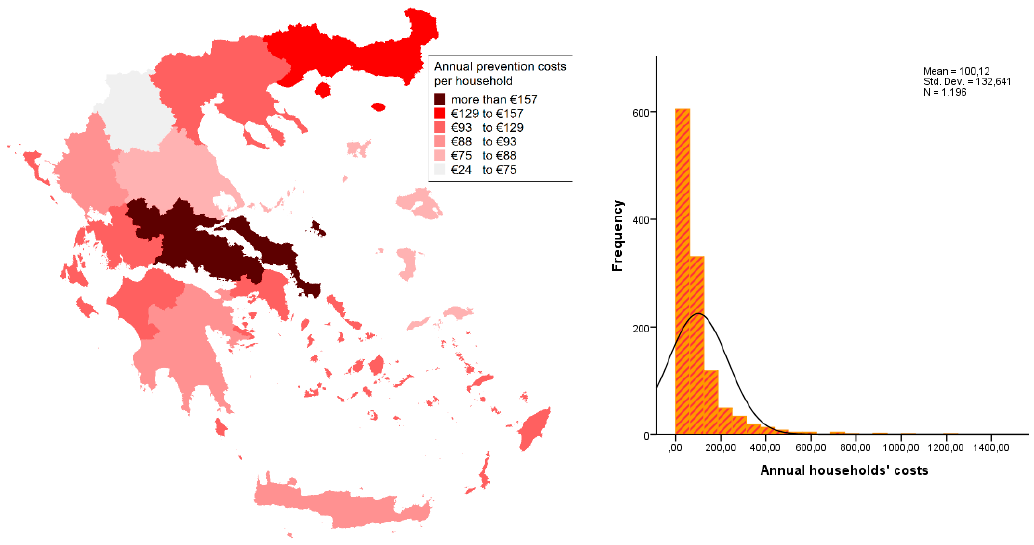
Figure 4. Annual prevention costs (€/year/household).